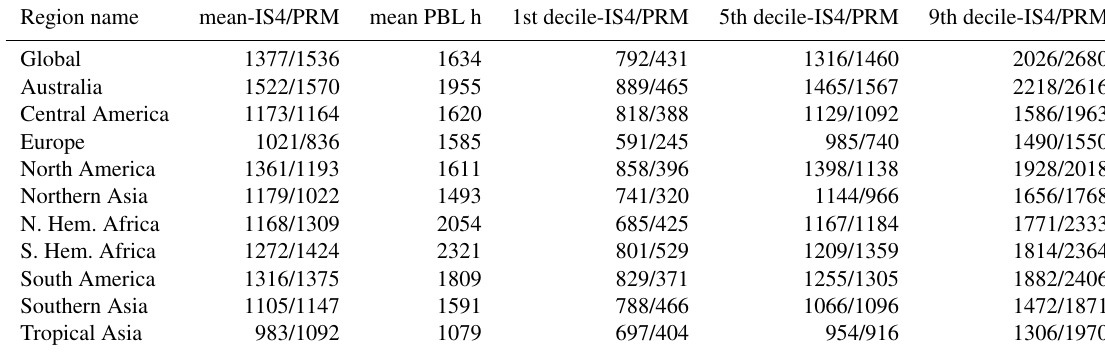
Figure 3. Comparison of the ECMWF boundary layer height diagnostic with the raw height of maximum injection from the PRM (top) and from the IS4FIRES algorithm (bottom) for the 1 June–1 August 2013 period. Observations used are from Terra (left) and Aqua (right). Table 1. Statistical analysis of the IS4FIRES and the PRM plume height in GFAS over the period 1 January 2003–1 January 2015, together with the mean of the PBL height diagnostic from the operational ECMWF model at the points where there were fires. All values are in metres and computed for the same fires. Only the non-null values were used in the computation of the statistics. IS4 stands for IS4FIRES parameterisation, PRM for plume rise